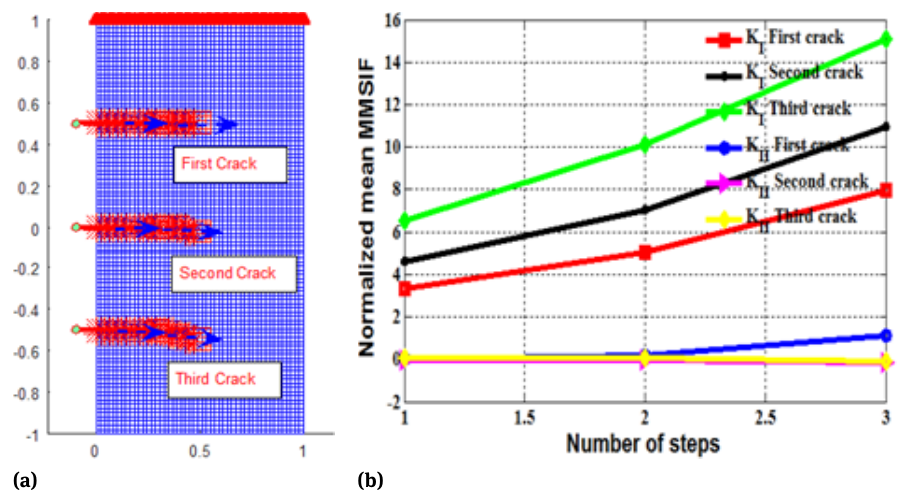
Figure 8: (a) Crack propagation path for triple edge crack plate under combined loading and (b) Normalized